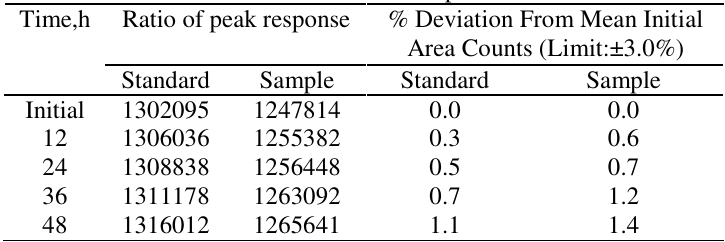
Table 1 . Peak response